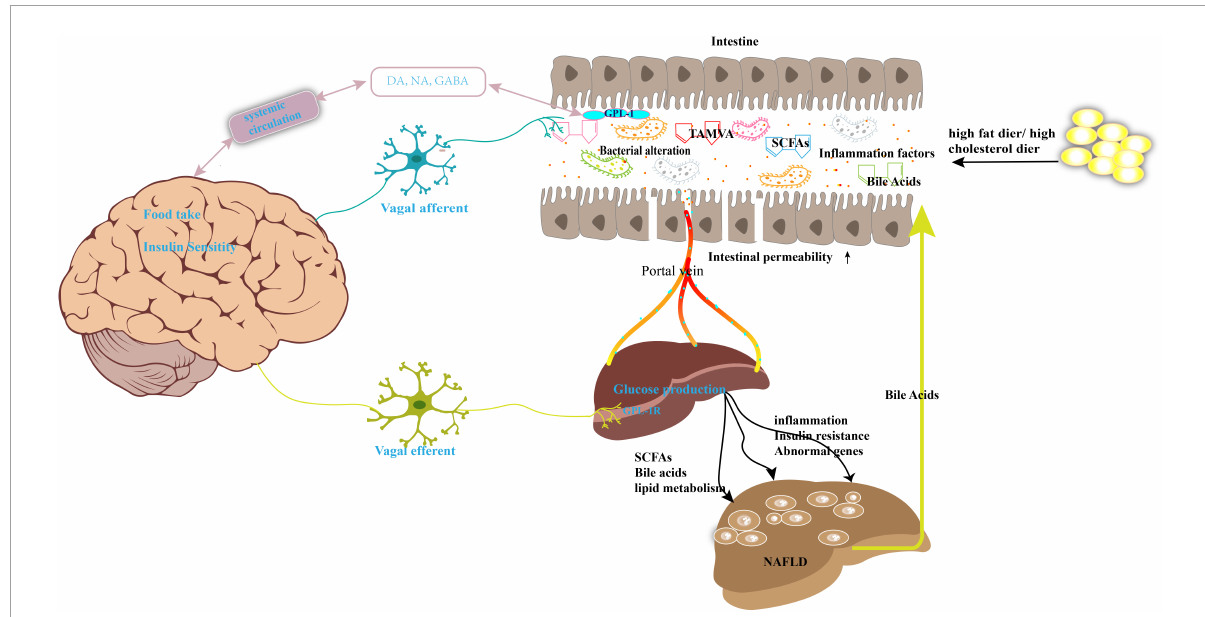
FIGURE1 Gut microbiota imbalance contributes to the development of NAFLD. High-fat diet or high-cholesterol diet may lead the nutrition imbalance and change the gut microbiota composition and its metabolites, such as SCFAs, bile acids, and TAMVA. Simultaneously, the intestinal permeability was enhanced, and microbiota and its metabolites reach the liver through the portal vein. This abnormal biology results in dysfunction of lipid metabolism, inflammation, and then NAFLD. The gut–brain–liver axis is also involved in NAFLD. Microbiota disorders promote the intestinal endocrine L cells to secrete GLP-1 to act on the vagus nerve to activate the gut–brain–liver nerve pathway and regulate the insulin sensitivity, glucose production, fatty acid oxidation. GABA, gamma-aminobutyric acid; DA, dopamine; NA, noradrenaline; SCFAs, short-chain fatty acids; TMAVA, N,N,N-trimethyl-5-aminovaleric acid; GLP-1, glucagon-like